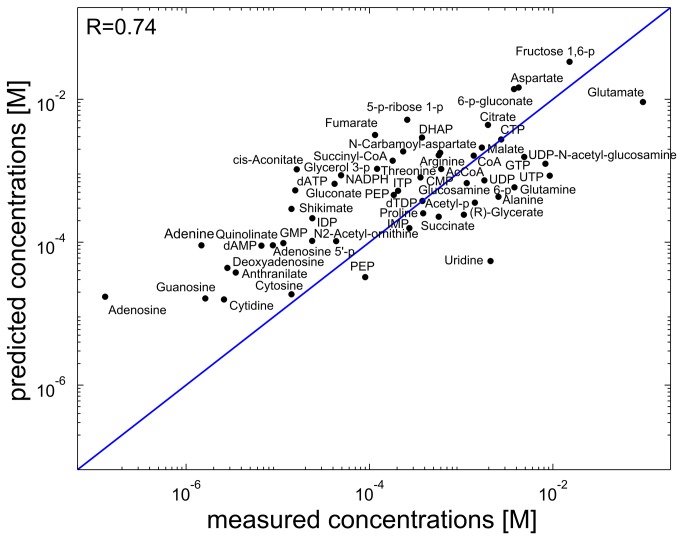
Measured metabolite concentration for aerobic glucose-fed E. coli versus predictions made by integrating mTOW with chemical properties-based concentration prediction.